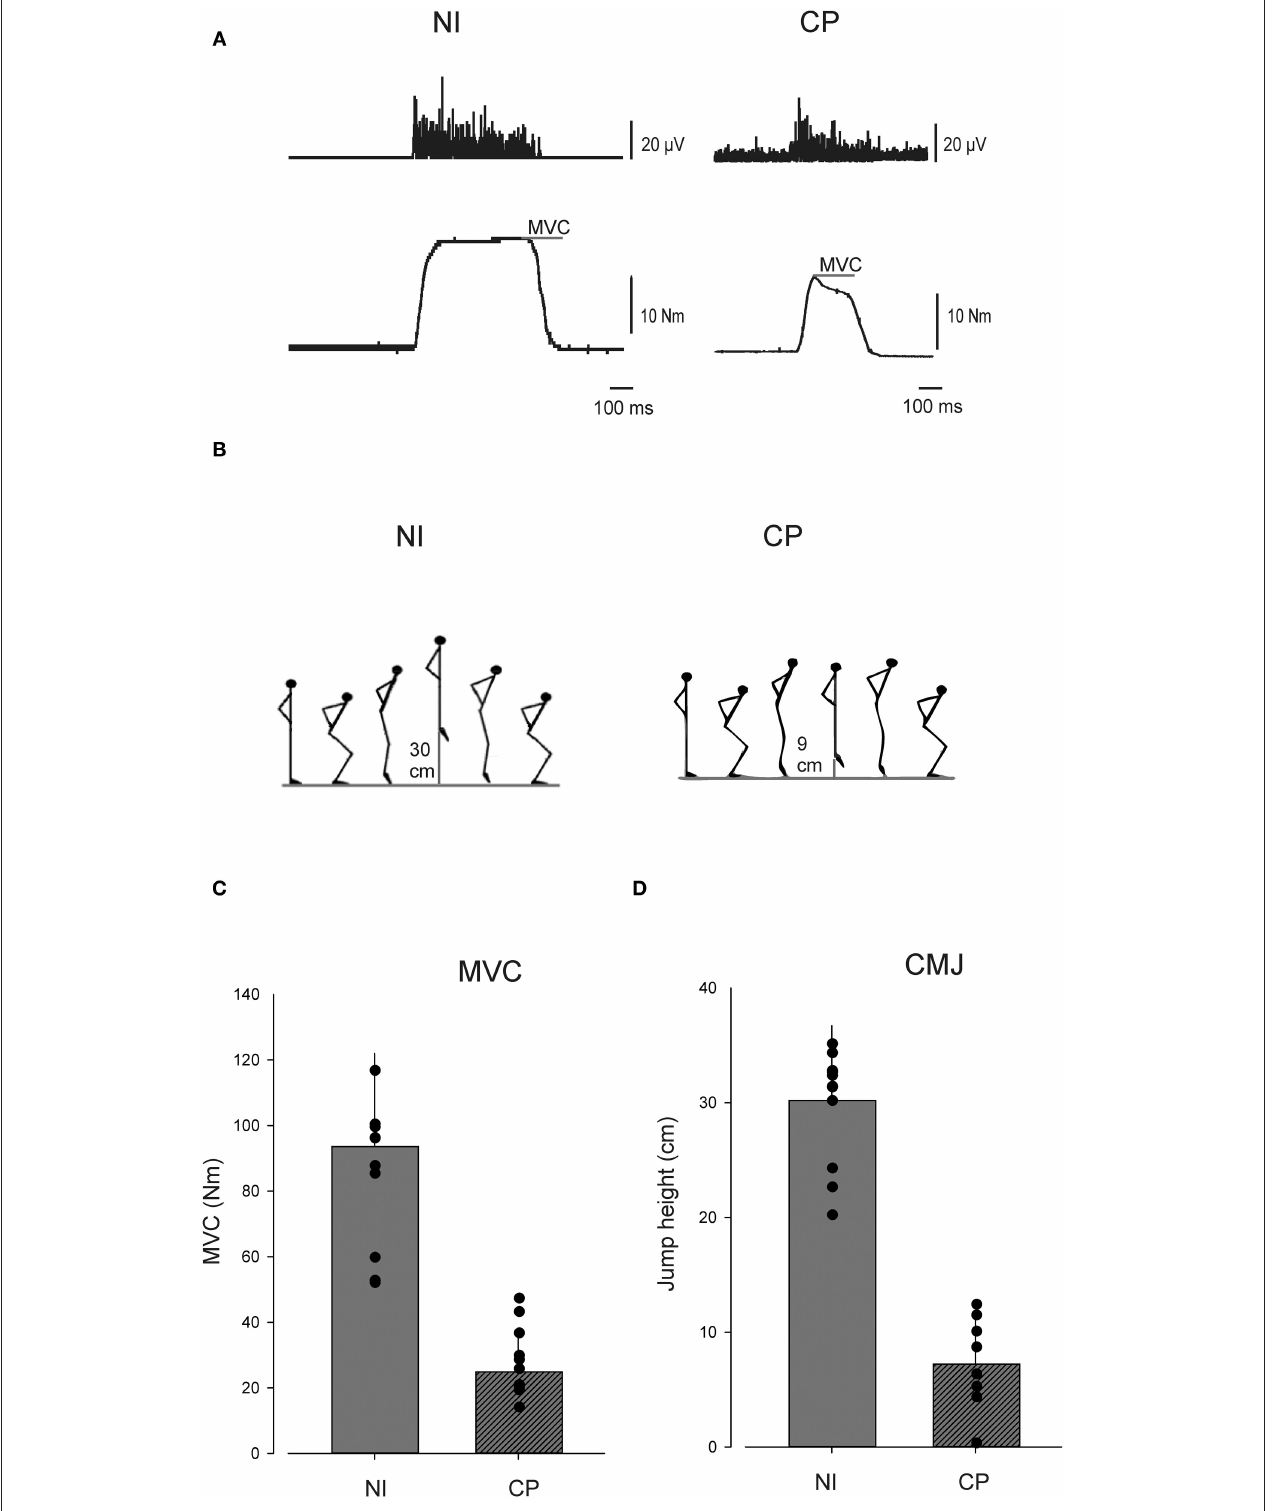
FIGURE 2 | Muscle function. (A) Show EMG and torque data from single individuals performing plantar flexion maximal voluntary contraction (MVC), (B) depicts a countermovement jump (CMJ). (C) Depicts MVC and (D) depicts CMJ in the cerebral palsy (CP) group and in the neurologically intact (NI) group. In (C,D) individual values are depicted as dots and group means as bars. Vertical lines indicate